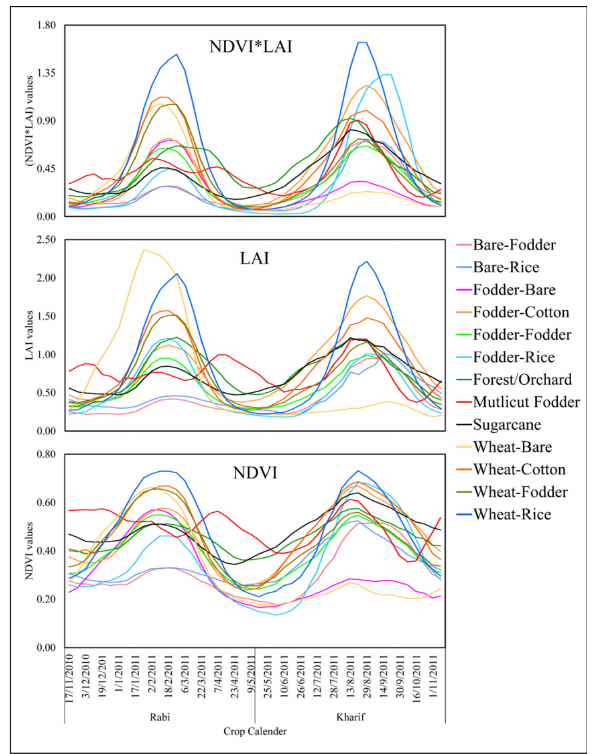
Figure 3. Phenological behavior of different crop rotation using NDVI, LAI and NDVI*LAI.